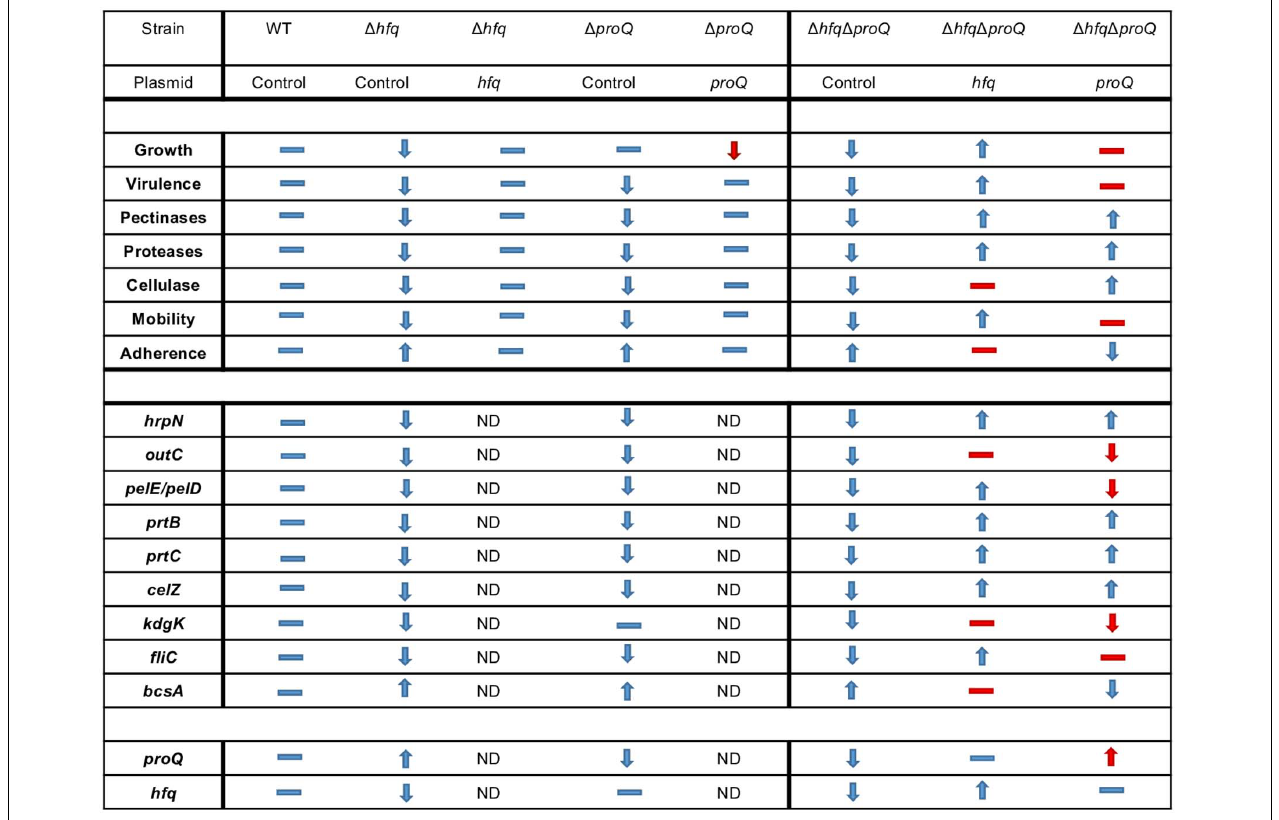
FIGURE 9 | Overview of phenotypes and variation of expression levels associated with the inactivation of proQ and hfq. Dash indicates equivalent phenotype (or expression level), up arrow indicates an increase in phenotype (or expression level) and down arrow indicates a decrease in phenotype (or expression level). The double mutant, single mutants and complemented single mutants were compared to the behavior of the wild-type strain whereas double mutant complemented with proQ or hfq were compared to the behavior of the double mutant without any complementation. Expected behavior is indicated in blue, unexpected behavior is indicated in red. ND: Not